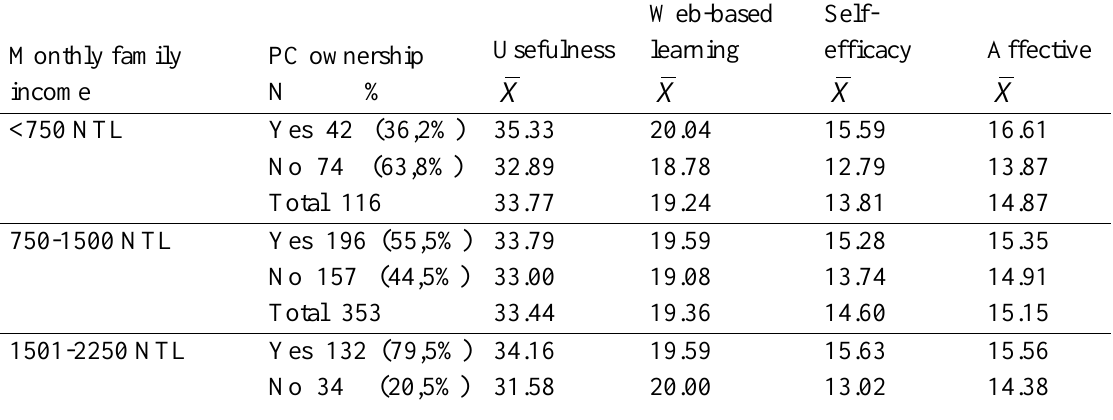
Descriptive Statistics for the Attitudes on the Subscales depending on Monthly Family Income and PC